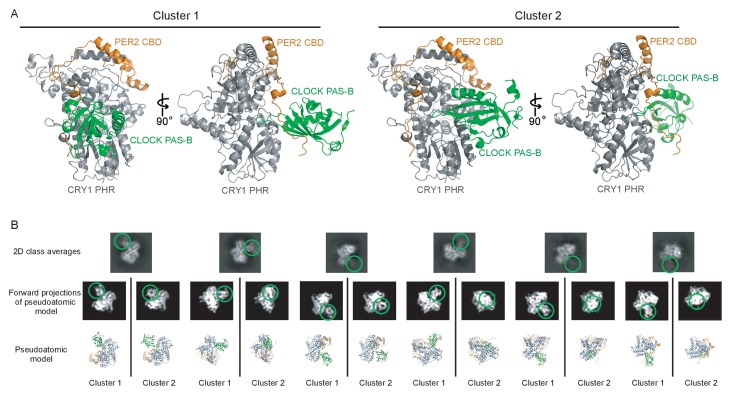
Representative HADDOCK models of the PER2 CBD:CRY1 PHR:CLOCK PAS-B complex and comparison to 2D class averages from cryo-EM data.(A) Representative structures of the top two HADDOCK clusters. Standard views of Cluster 1 (left) and the complex rotated 90° and Cluster 2 (right) are depicted. (B) Comparison between 2D class averages (top row) from the cryo-EM data and the two pseudoatomic models of CRY PHR:PER2 CBD bound to CLOCK PAS-B generated from HADDOCK (Cluster 1 and Cluster 2). Forward projections (middle row) of the pseudoatomic models (bottom row) were generated to match the angular orientations observed in the experimental data. The general position of the CLOCK PAS-B domain is denoted with a green circle for both 2D class averages and forward projections of the pseudoatomic models. CLOCK PAS-B appears to adopt a range of orientations, leading it to become blurred in some 2D class averages. See Supplementary file 2 for more information.